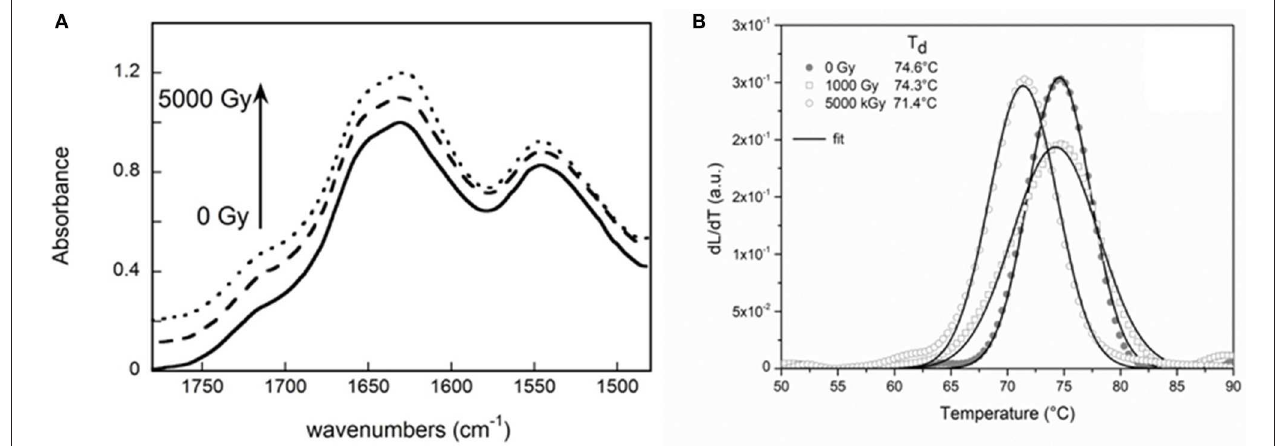
FIGURE 4 | Structural evaluation of the leather damage and bulk evaluation of the leather damage. (A) FTIR spectra in the Amide I and Amide II region of not irradiated sample (black curve), of the leather irradiated with a dose of 1,000Gy (dashed curve) and with a dose of 5,000Gy (dotted curve); (B) LTA curves of the not irradiated sample (black dots curve), of the leather irradiated with a dose of 1,000Gy (white squares curve) and with a dose of 5,000Gy (white dots curve). A slight difference can be observed in the Td of the sample irradiated with 1,000Gy with respect to the non-irradiated one while a large decrease of the denaturation temperature characterizes the sample irradiated with 5,000Gy, thus revealing a significant deterioration induced by such irradiation